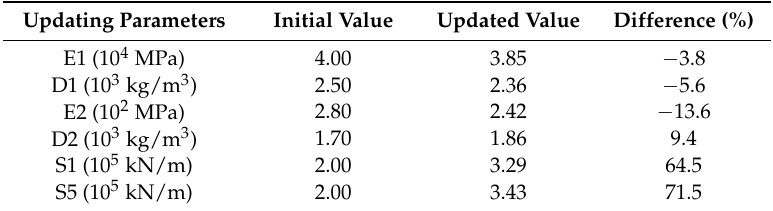
Table 3. Comparison between initial values and updated values of updating